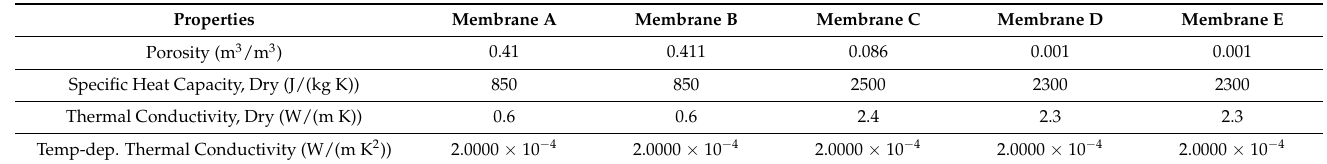
Table 1. Properties adopted from existing materials within the software materials database.